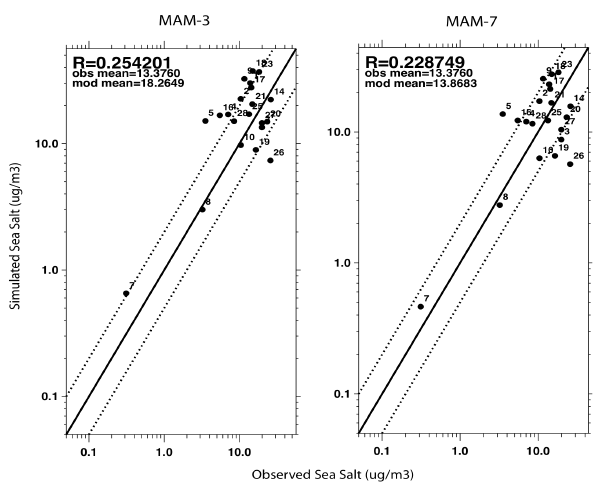
Fig. 20. Same as Fig. 10, but for sea salt concentrations (µgm − 3 ) . Figure 20. Same as Fig. 10, but for sea salt concentrations ( µ g m -3 ). The global locations The global locations of sites denoted by different numbers in the of sites denoted by different numbers in the figure can be found in Wang et al. (2011). figure can be found in Wang et al. (2011).